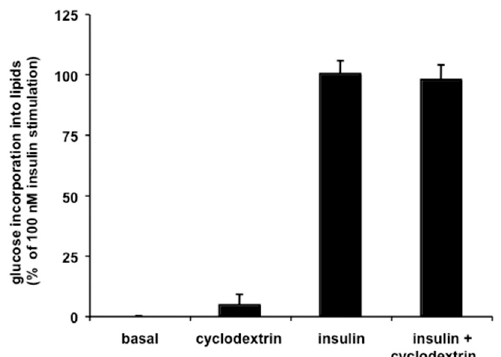
Figure 5. Lipogenic activity was measured during 120 min with adipocytes freshly isolated from mouse intra-abdominal fat depots. Final concentration of insulin was 100 nM, while methyl- β -cyclodextrin was tested at 1 mM. In C57Bl6 mouse adipocytes, the insulin effect was equivalent to a 2.7 ± 0.2-fold increase over basal lipogenesis. Lipogenesis was expressed as a percentage of maximal insulin-induced activation, with basal values set at 0%. Mean ± SEM of 13–20 preparations.